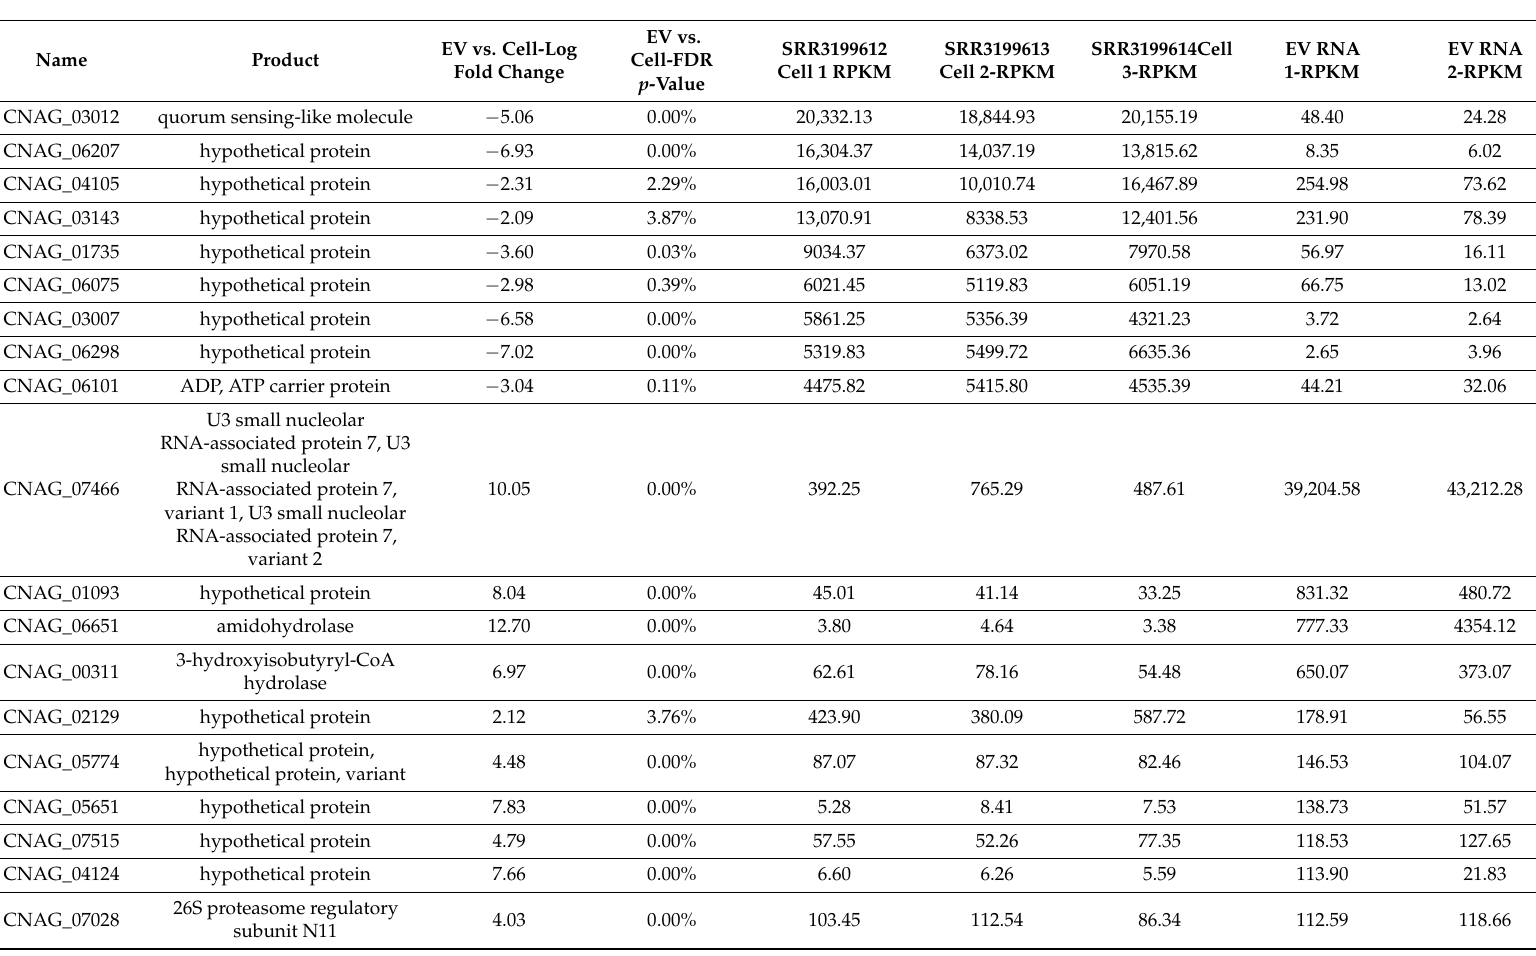
Table 2. Comparison between cellular and vesicular RNA in C. neoformans (H99 strain). The top ten most expressed transcripts in the cell are shown in light blue. The most represented RNAs in the EVs are illustrated in light